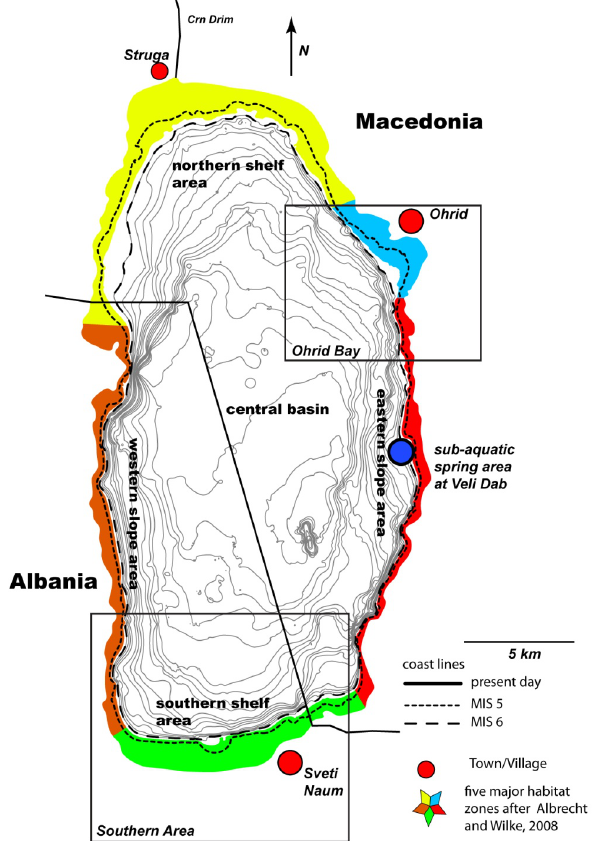
Fig. 9. Map of Lake Ohrid with major habitat zones (Albrecht and Wilke, 2008). Ancient coastlines as reconstructed in the study are shown as dashed lines. For details see text.